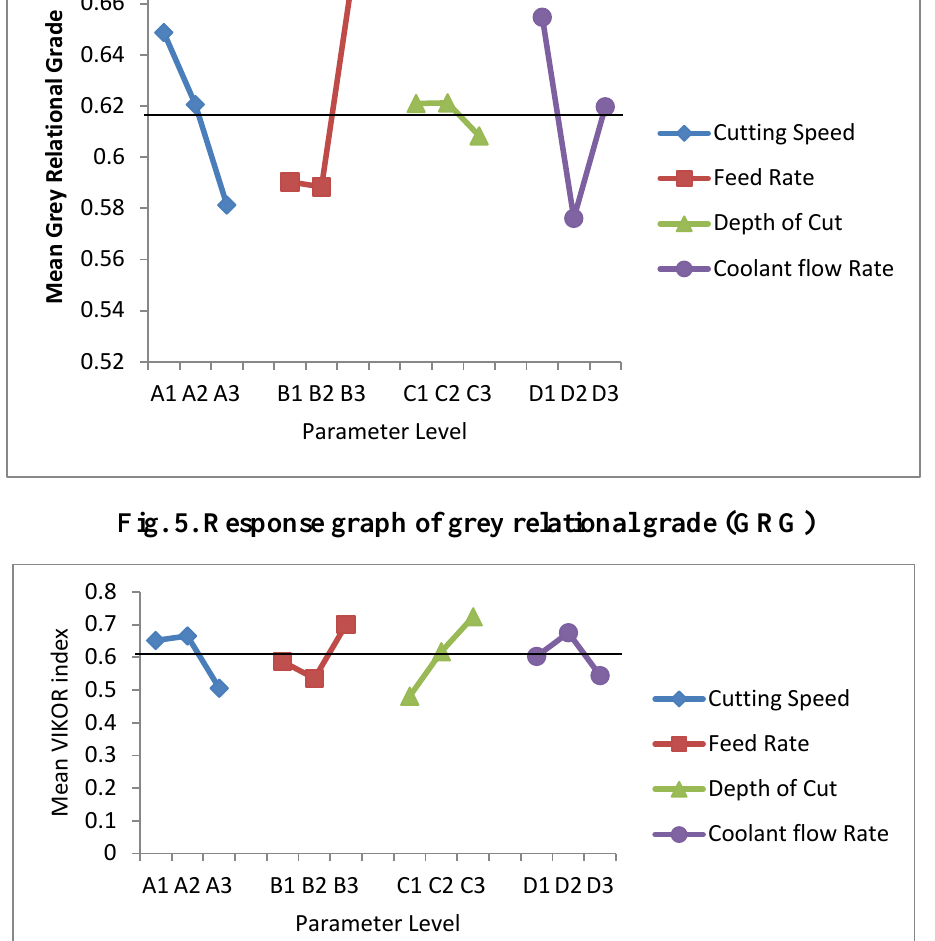
Fig. 6. Response graph of VIKOR